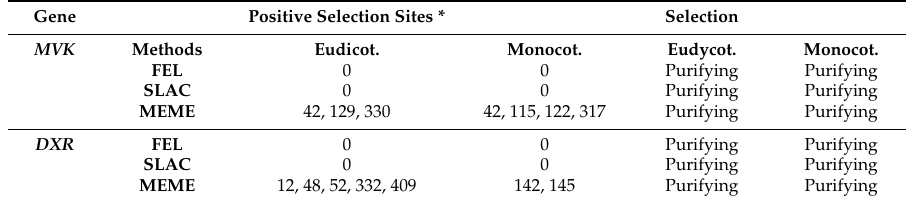
Table 3. Predicted number and location of codons under positive selection in MVK and DXR. Gene Positive Selection Sites * Selection MVK Methods Eudicot. Monocot. Eudycot. Monocot. FEL 0 0 Purifying Purifying SLAC 0 0 Purifying Purifying MEME 42, 129, 330 42, 115, 122, 317 Purifying Purifying DXR FEL 0 Purifying Purifying SLAC 0 Purifying Purifying MEME 12, 48, 52, 332, 409 142, 145 Purifying